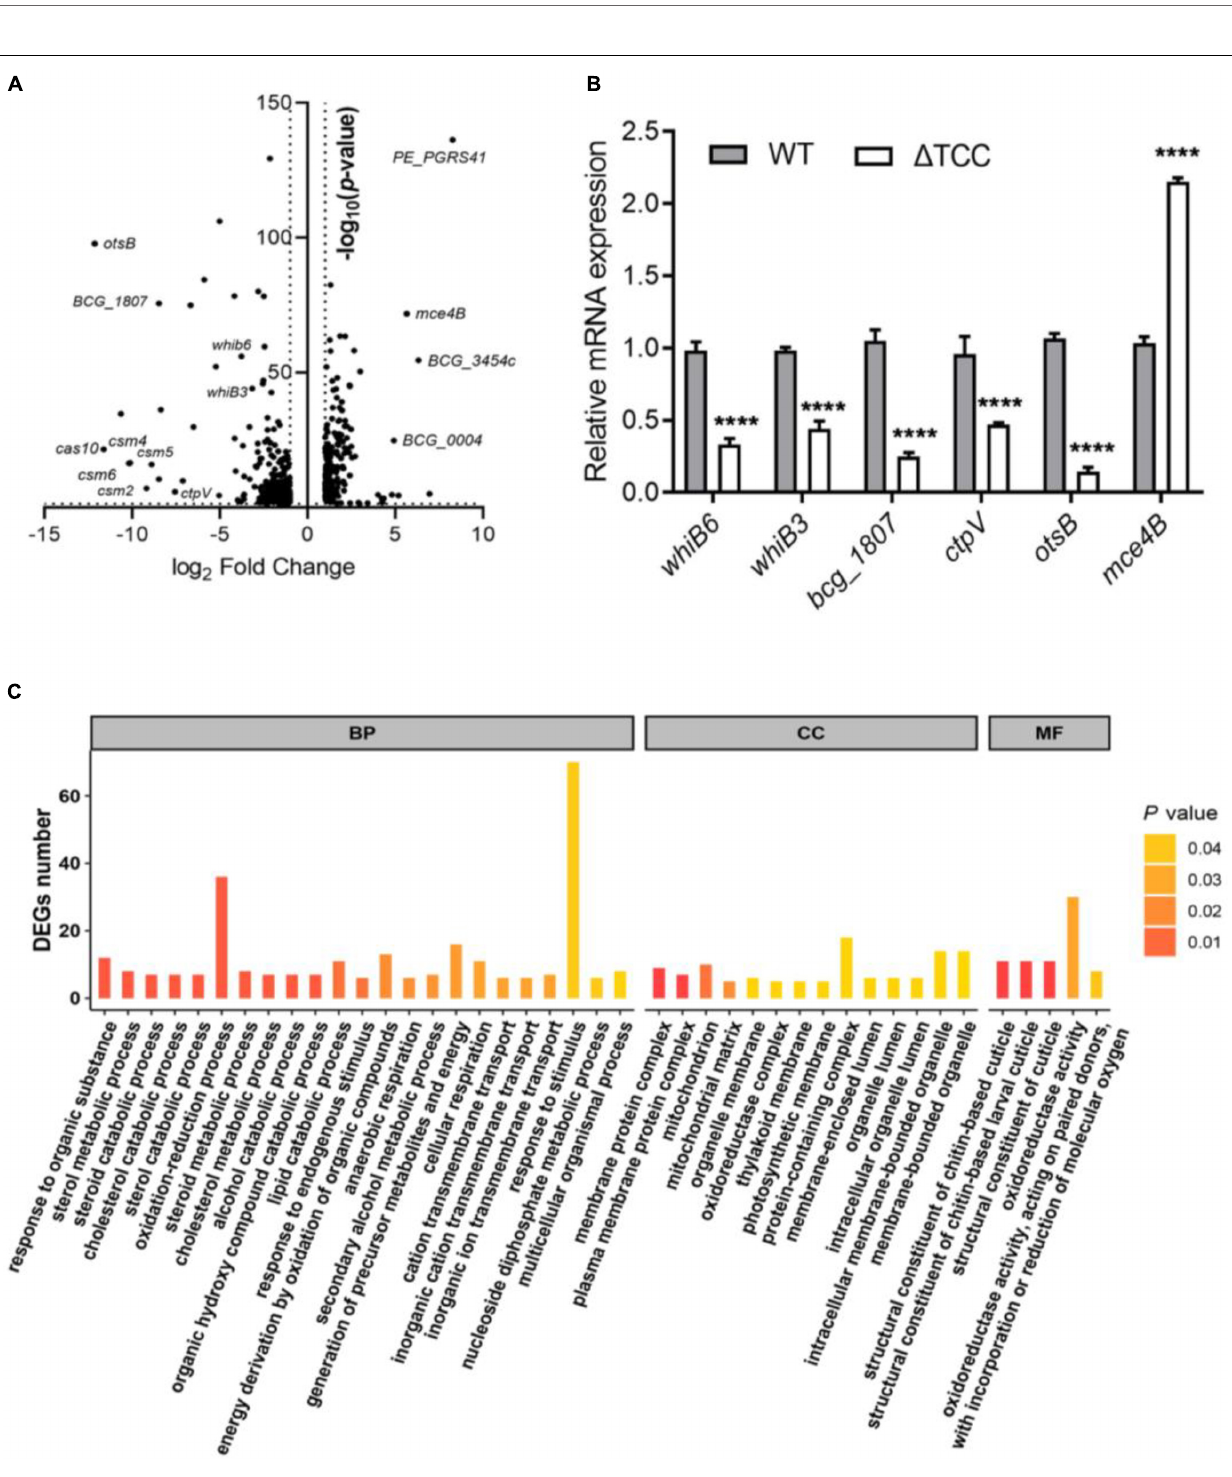
Frontiers in Microbiology |